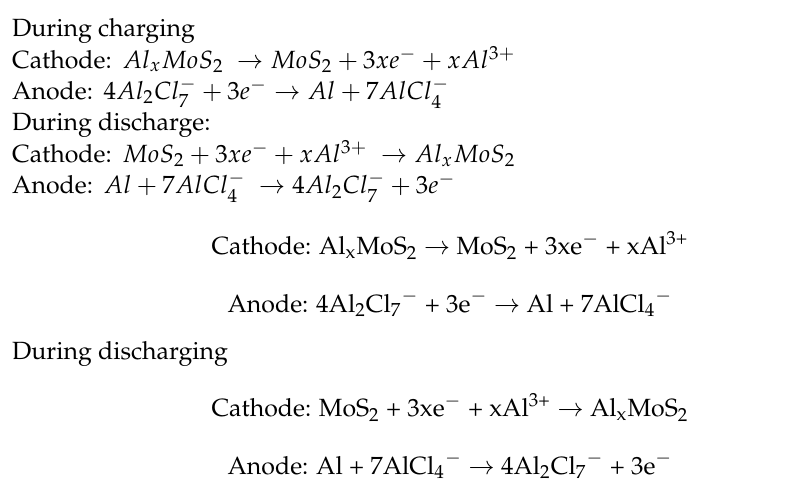
Figure 3. ( a ) Charge–discharge profile, ( b ) cycling performance, and ( c ) rate capability of the 1T- MoS 2 /SP-1–urea battery at 60 ◦